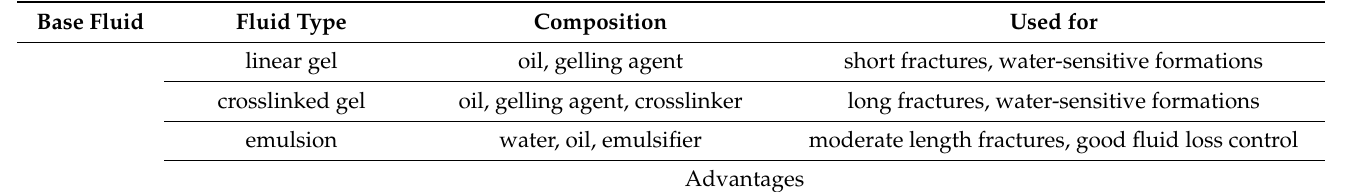
Table 5. Oil-based fracturing